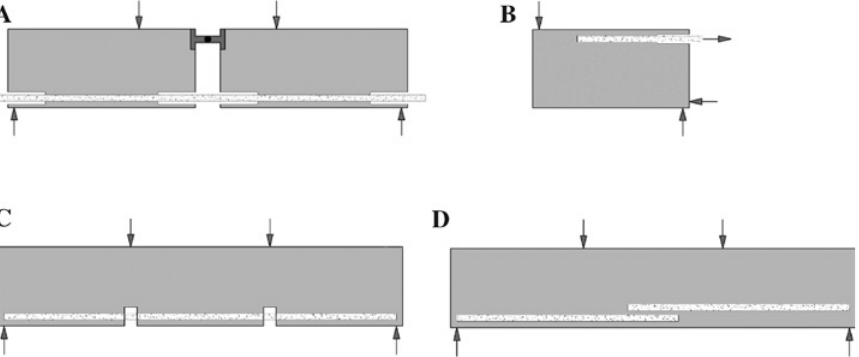
Figure 2: Beam tests for bonding. (A) Hinged beam test. (B) Beam end specimen (inverted hinge beam). (C) Beam anchorage specimen. (D) Beam splice specimen.